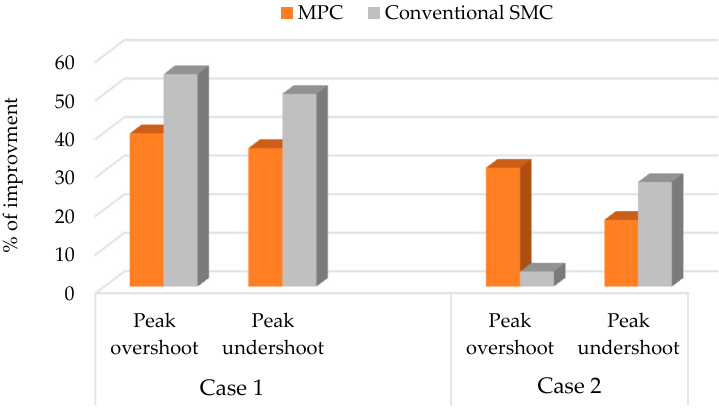
Figure 10. Percentage of improvement of the suggested technique over the MPC and conventional SMC controllers.